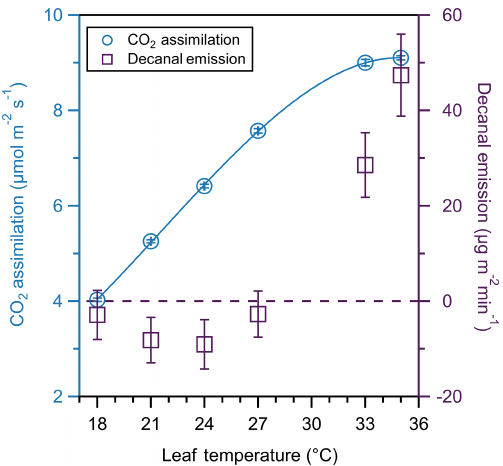
Figure 8. CO 2 assimilation (blue circles) and decanal emission (purple squares) temperature response curve of one basil leaf. CO 2 assimilation is fit to a cubic function. We collected CO 2 assimila- tion values 10 times over 20min and averaged the values; error bars represent the standard deviation of those measurements. Error bars for decanal emissions represent instrumental error. The dashed line denotes 0µgm − 2 min − 1 of decanal